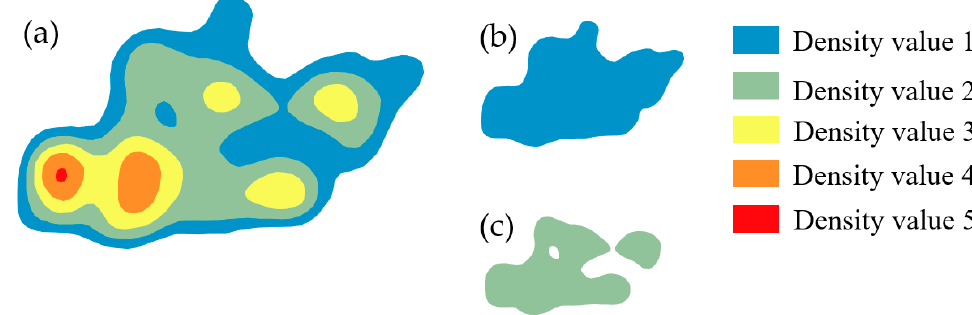
Figure 6. Illustration of different density values and corresponding urban sprawl extents: ( a ) is the KDE result, ( b ) is the obtained urban area with density values of 1 or greater, and ( c ) is the obtained urban areas with density values of 2 or greater.